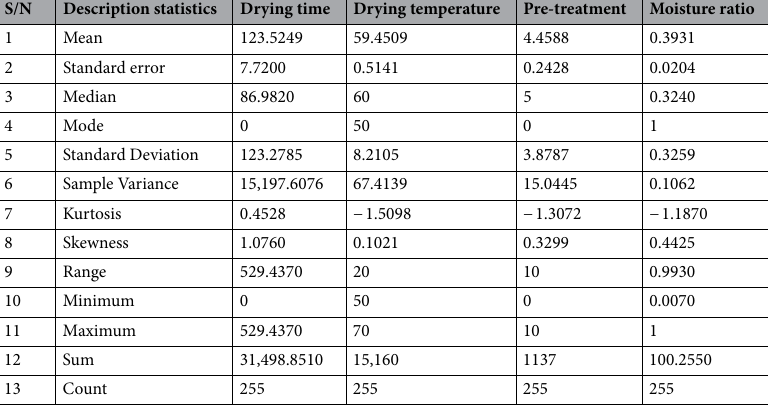
Table 3. Description of the experimental data.